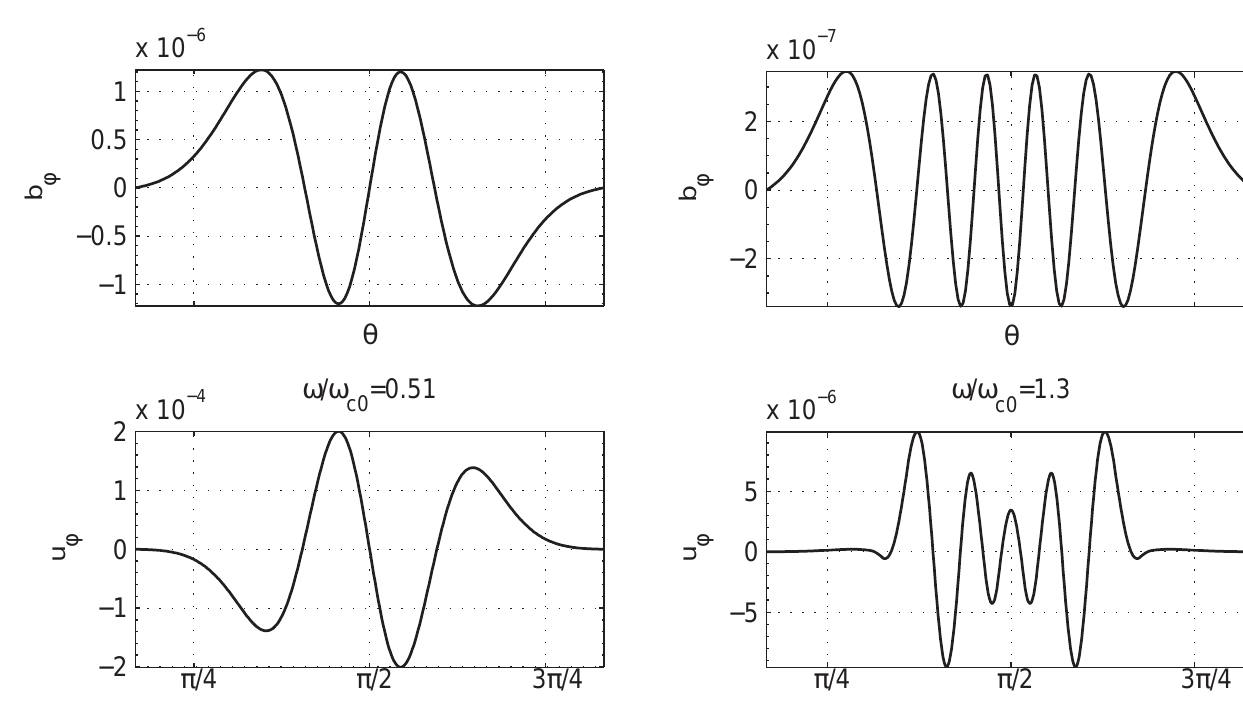
Fig. 7. Solution of the KG equation for L = 4 ,p = 3 : higher-order harmonic.